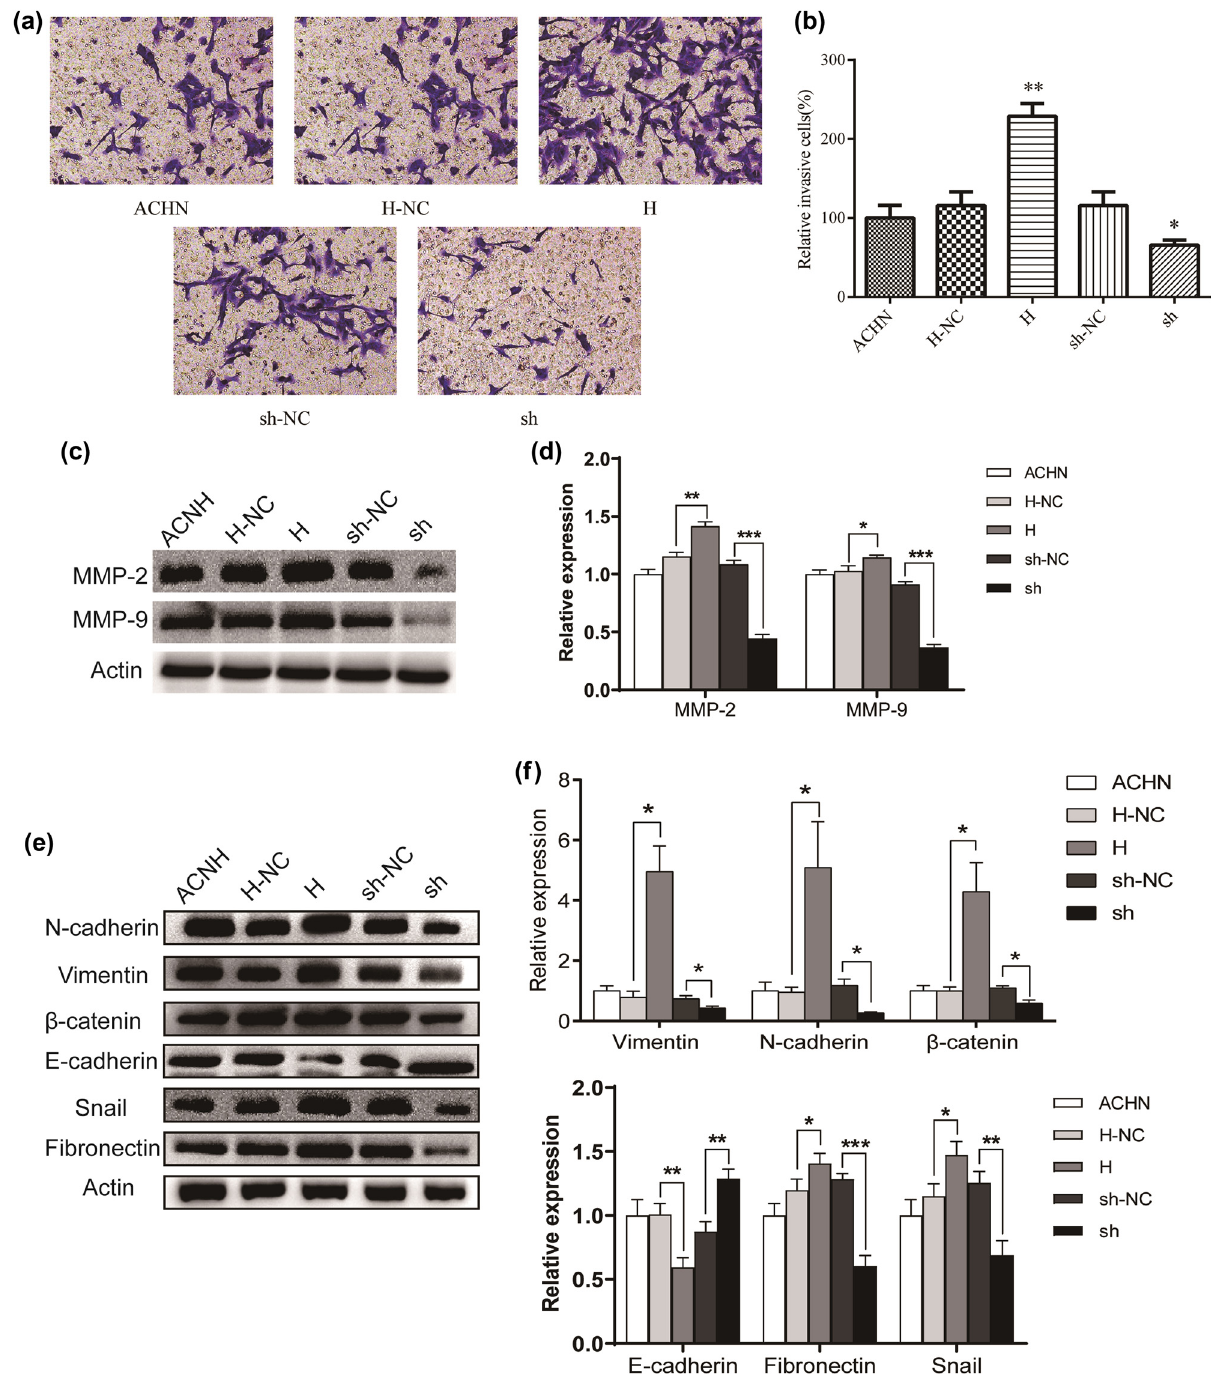
Figure 4: Trim24 promoted the invasion and induced epithelial - to - mesenchymal transition ( EMT ) process in ACNH cells. ( a ) Invasive cells were photographed ( 200 × magni fi cation ) after incubated in transwell chambers with matrigel for 48 h. ( b ) Counting and analysis of invasion cell numbers. ( c ) Expressions of MMP - 2 and MMP - 9 were detected by the western blot. ( d ) Gray scale was analyzed using Image J software. ( e ) Expressions of key proteins in the EMT process were detected by western blot. ( f ) Gray scale of EMT key proteins was analyzed using Image J software. * P < 0.05, ** P < 0.01, and *** P <